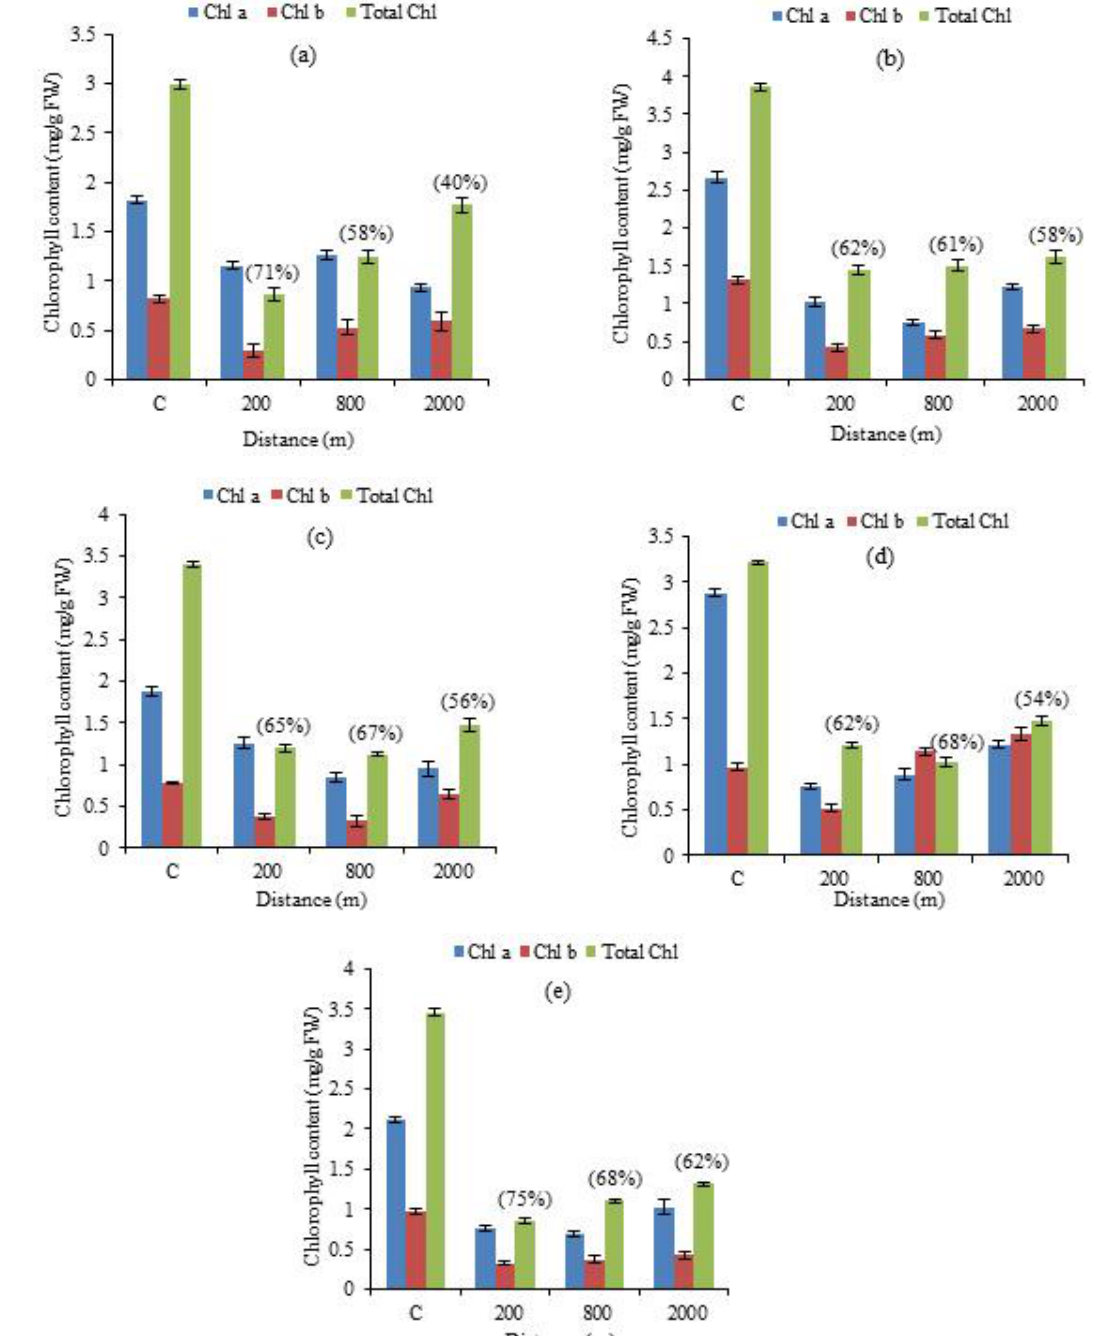
Fig. 3: Chlorophyll content ( a, b and total) (mg g -1 FW.) and percentage decrease over control in study area’s Hordeum vulgare L in the age of 20 (a), 40 (b), 60 (c), 80 (d) and 100 days